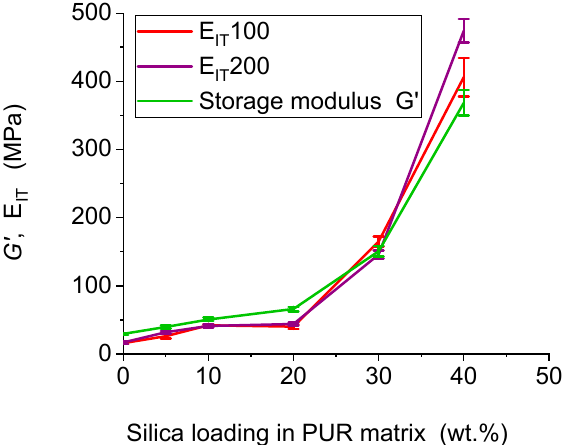
Figure 9. Overlay of trends of elasticity-related magnitudes determined by microindentation ( E IT 100 and E IT 200) and by DMTA (storage modulus G’), all as a function of nanofiller loading, all measured at T = 25 °C.